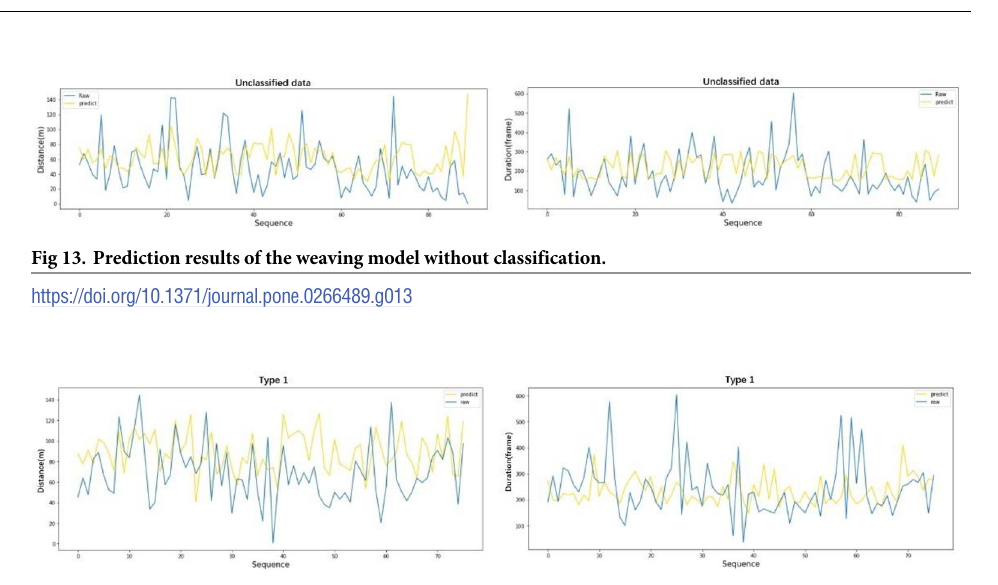
Fig 14. Prediction results of the weaving model for type 1.